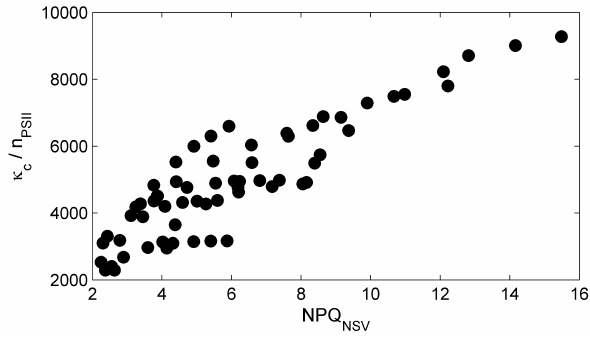
Figure 7. Correlation between the conversion factor K c /n PSII and the expression of NPQ NSV . NPQ NSV was derived as F (cid:48) o /F (cid:48) v (McKew et al., 2013), for each step of the FRRF light curve at each TP. Values of K c /n PSII corresponding to the same light inten- sities were derived by extrapolation along the carbon fixation and ETR RCII -based P vs. E